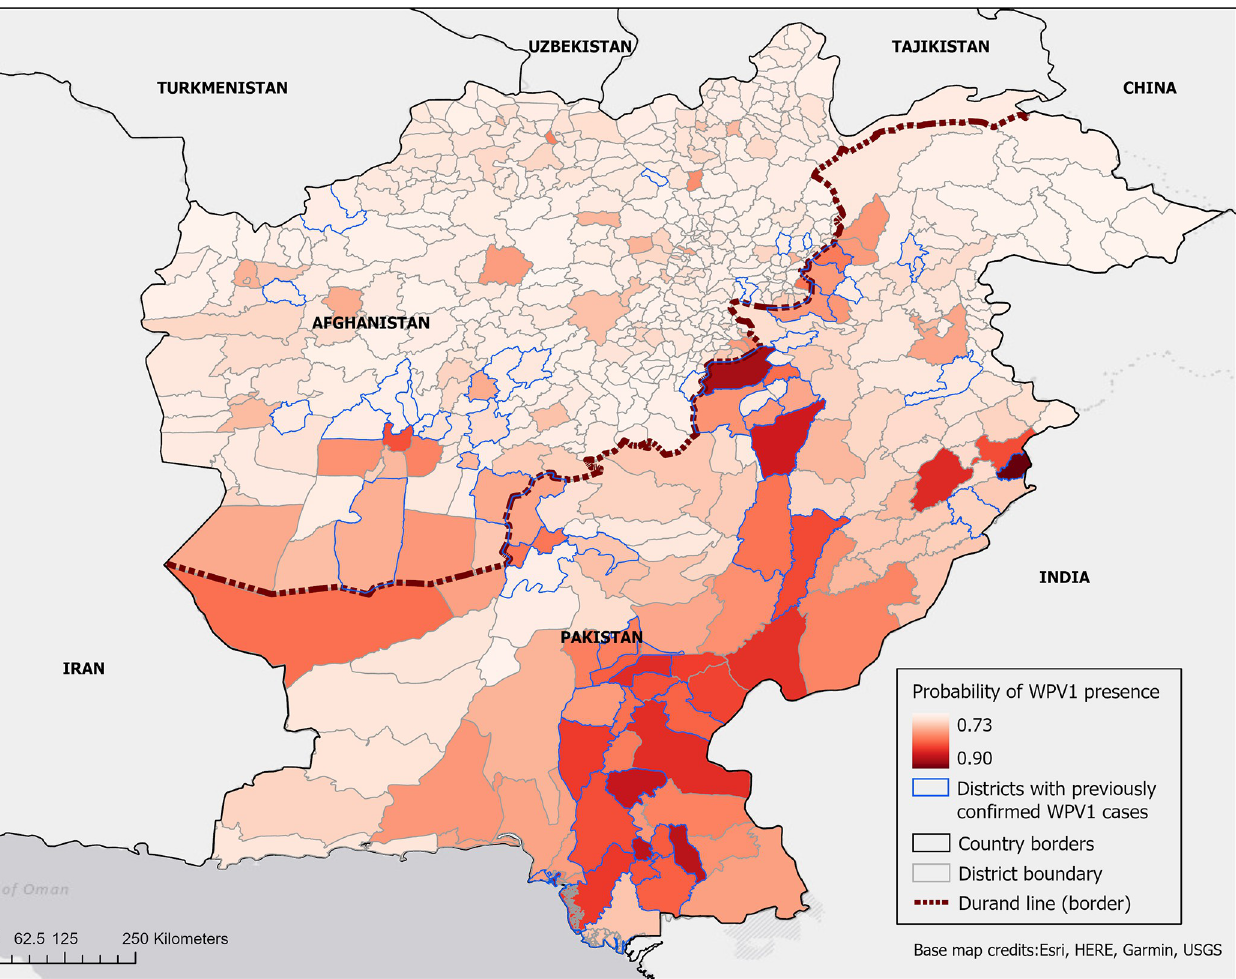
Fig 5. Probability of WPV1 presence in Afghanistan and Pakistan based on results of generalized linear